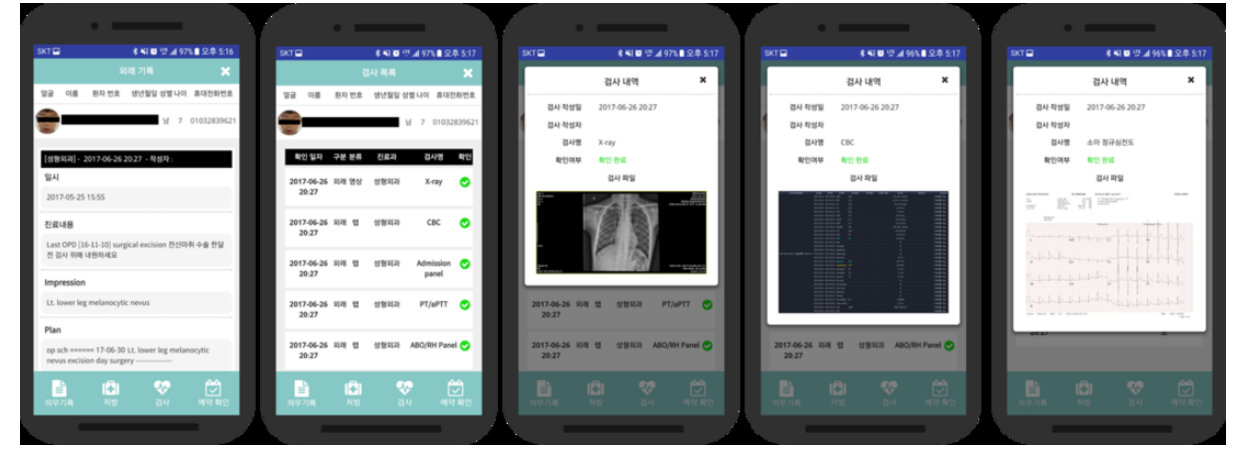
Figure 5. Medical recordings and examination.